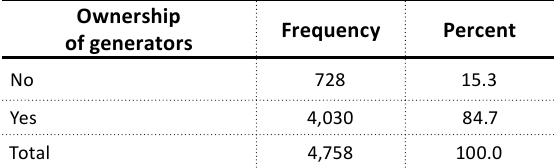
Table 13. Ownership of electric generating set